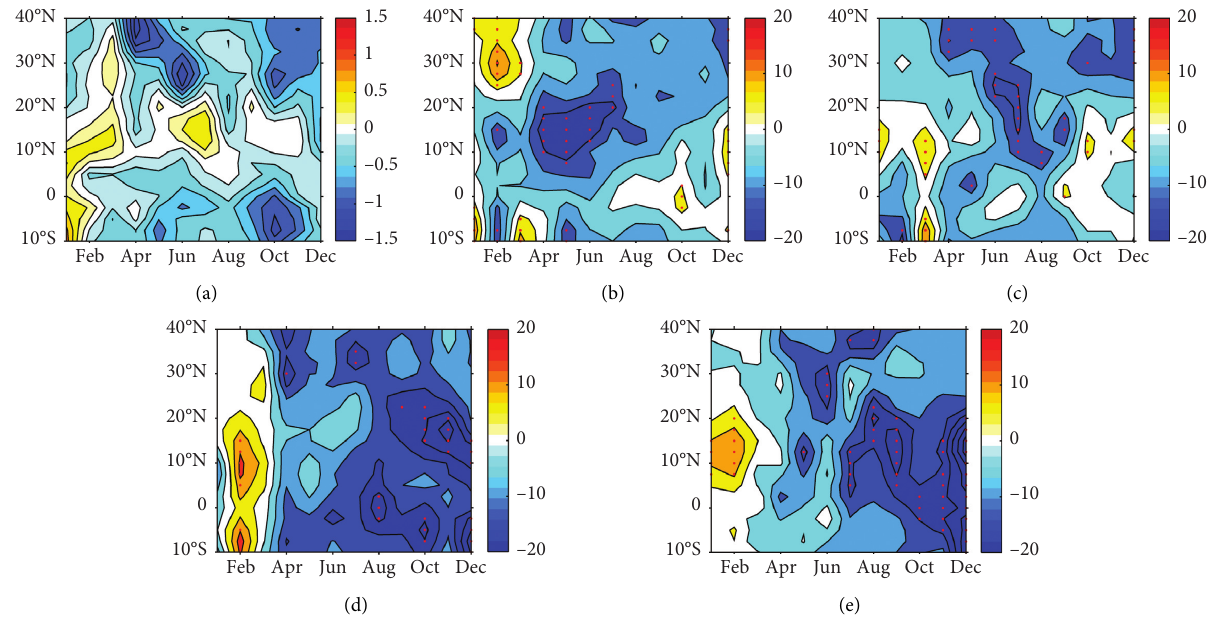
Figure 10: Composite OLR anomalies averaged over the western Pacific (110 ° –140 ° E) in the CP El Niño decaying months for (a) climatology (averaged for the period of 1950–2017), (b) cool PDO in developing summers, (c) warm PDO in developing summers, (d) cool PDO in decaying summers, and (e) warm PDO in decaying summers. Red dots indicate 95% and higher confidence levels using t -test for OLR anomalies.